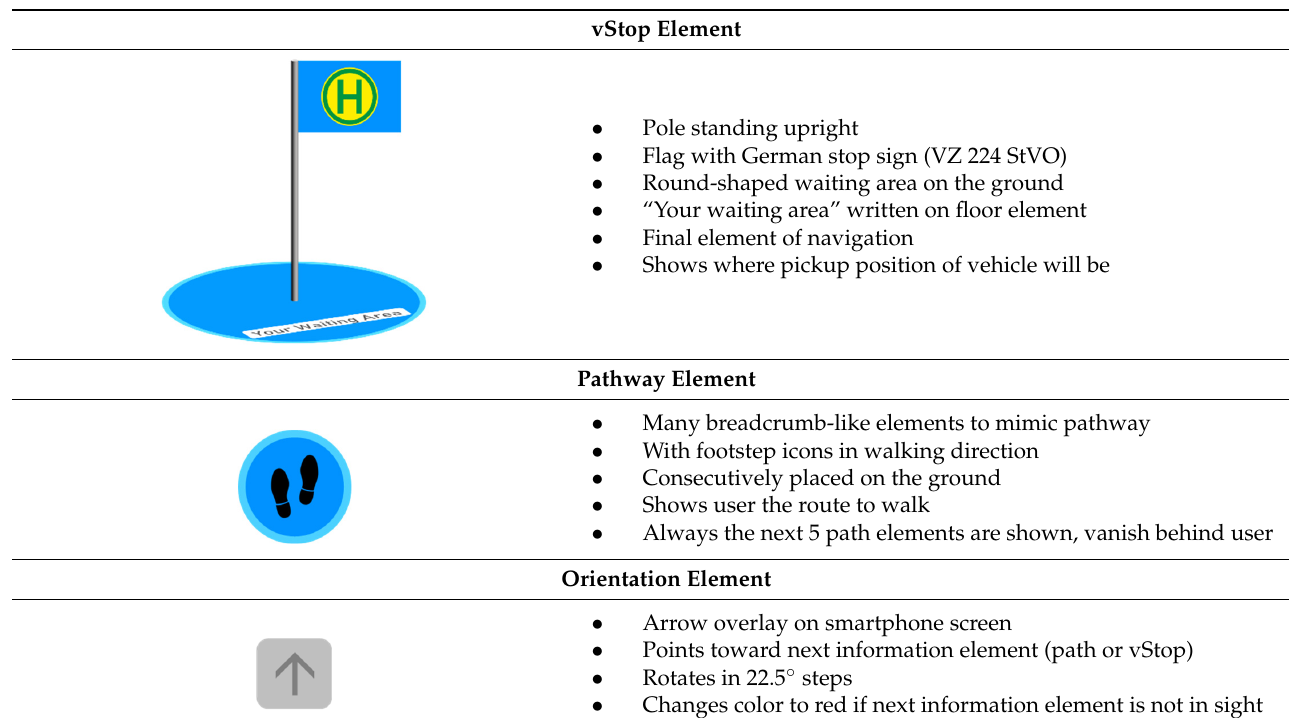
Table 3. vStop information elements of AR HMI prototype. vStop Element